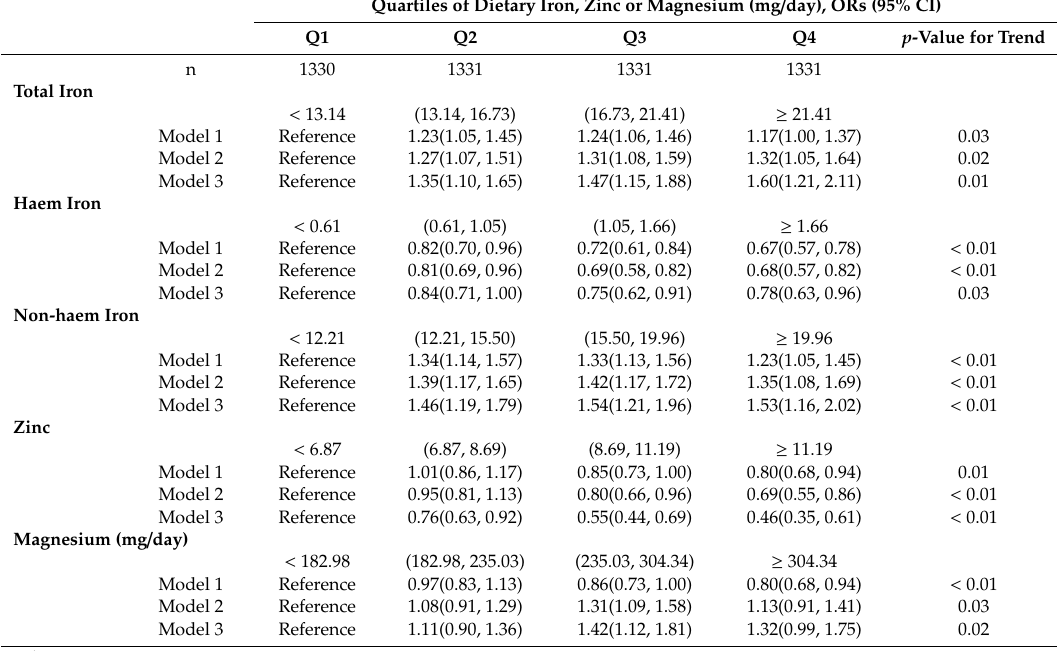
Table 3. Odds ratios (ORs) (95% CI) for metabolic syndrome (MetS) according to the quartiles of dietary iron, zinc and magnesium intakes (mg / day) in 5323 participants from CNHS and SDHS 1, 2 .